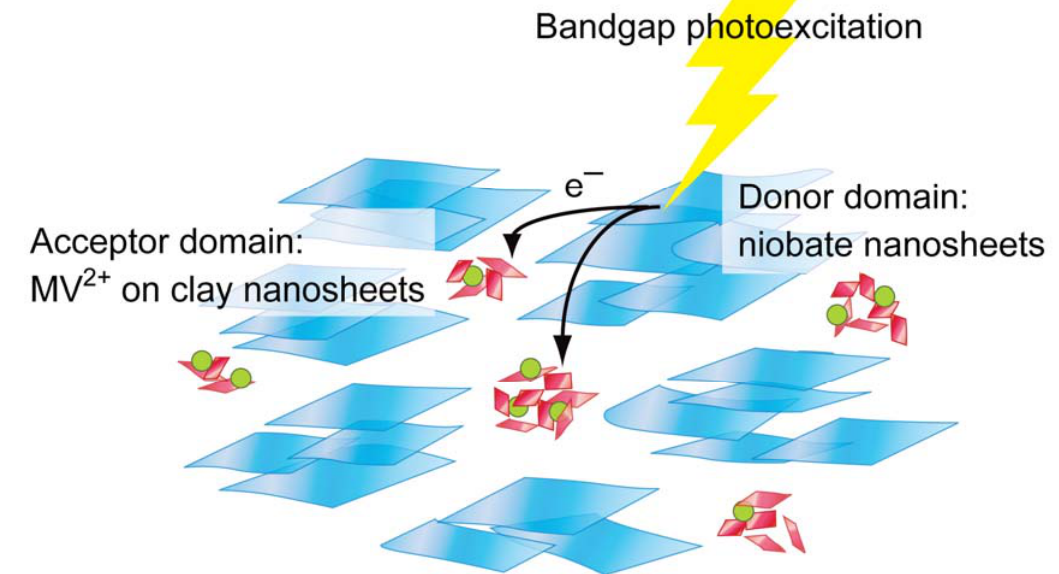
Figure 10. Schematic representation of the photoinduced electron transfer in the clay– niobate nanosheet colloids added by methylviologen (MV 2+ ) species as electron acceptor [186]. Reprinted with permission from Ref. [186]. Copyright 2009 American Chemical